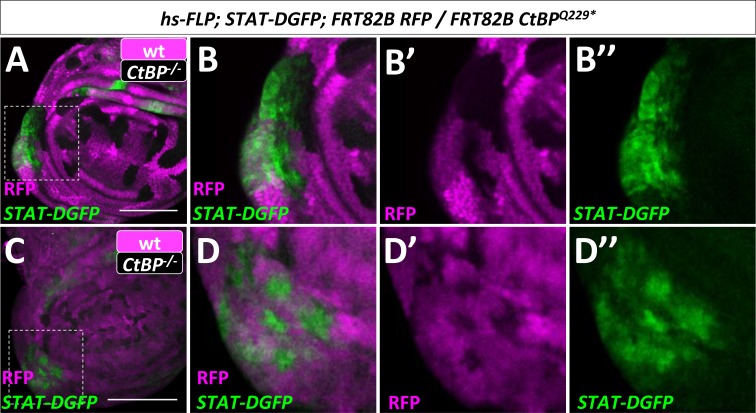
Effect of reducing CtBP function on STAT activity.Wing discs with homozygous mutant clones of CtBPQ229* with the STAT-DGFP reporter. CtBP-/- mutant clones are marked by the absence of RFP. Areas in the white dotted box in (A) and (C) are enlarged in the subsequent panels (B–B”) and (D–D”).